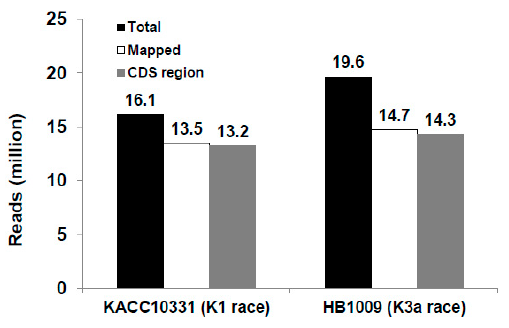
Figure 2. Total number of R-seq reads from each Xanthomonas oryzae pv. oryzae strain library and mapped reads to the Xanthomonas oryzae pv. oryzae KACC10331 genome.